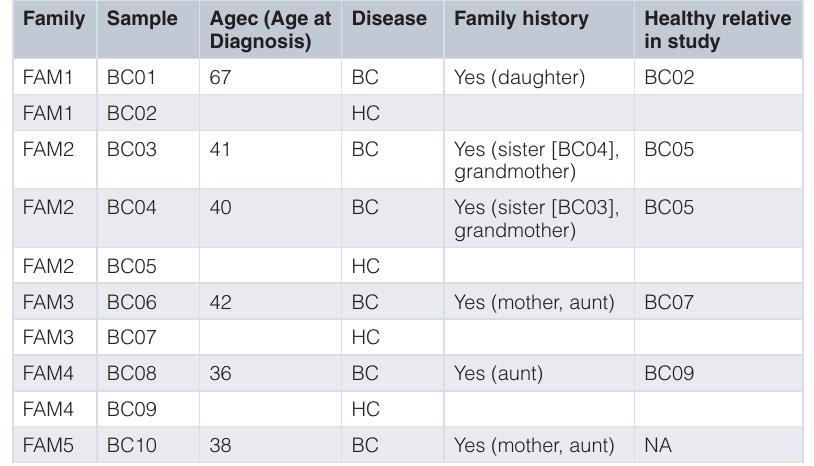
Table 1. Family structure of the studied